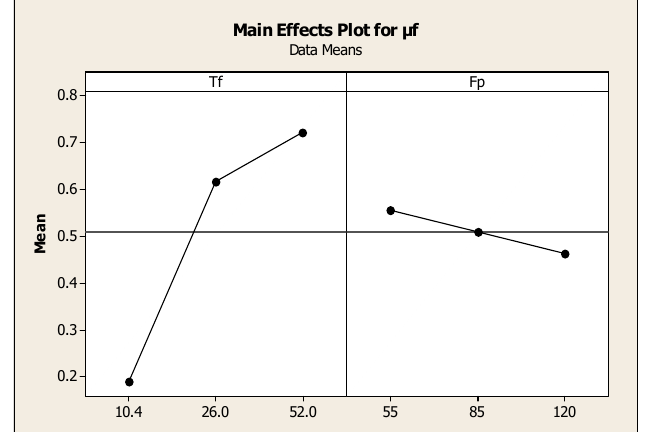
Figure 10. Effect of friction pressure and torque on µ f .